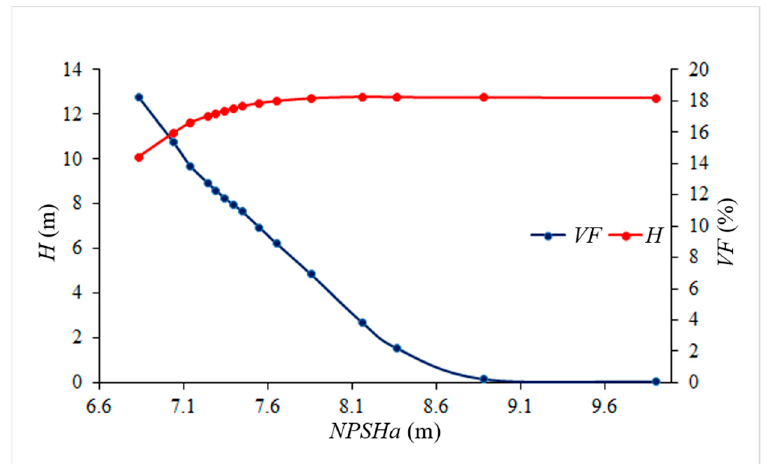
Figure 9. The VF of the impeller blade surface.